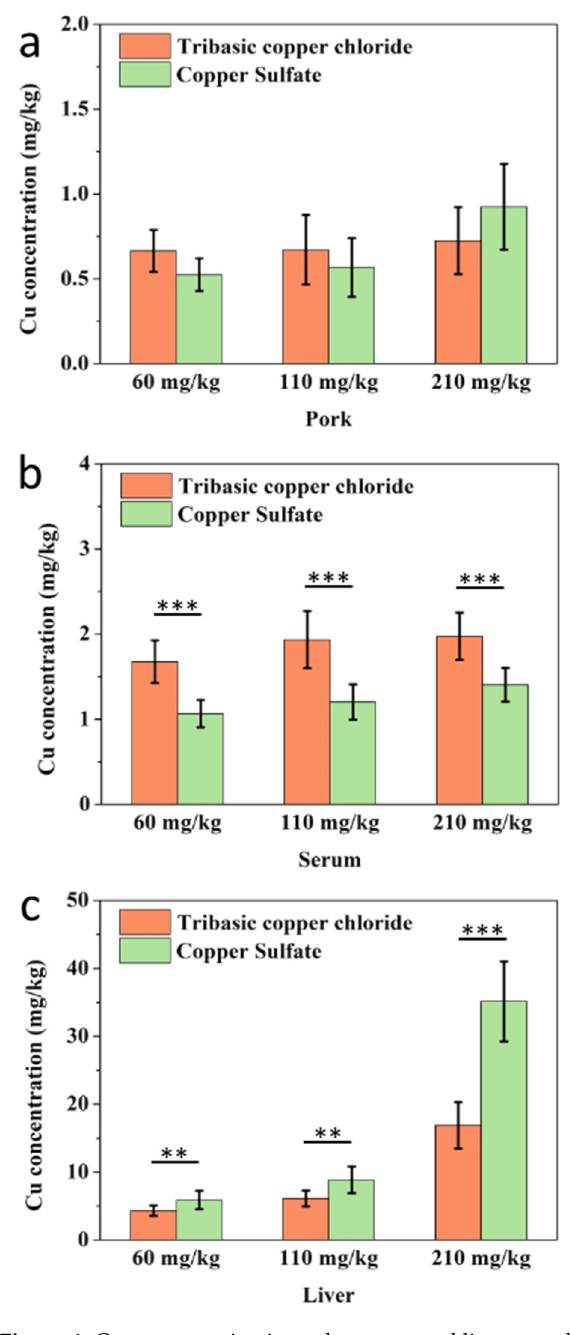
Figure 4. Cu concentration in pork, serum, and liver sample by ic-ELISA for ( a ) copper concentration in pork; ( b ) copper concentration in serum; ( c ) copper concentration in liver. (*: p < 0.05, **: p < 0.01, ***: p < 0.001). p -values represent the difference among three groups as determined by Student’s t - test.